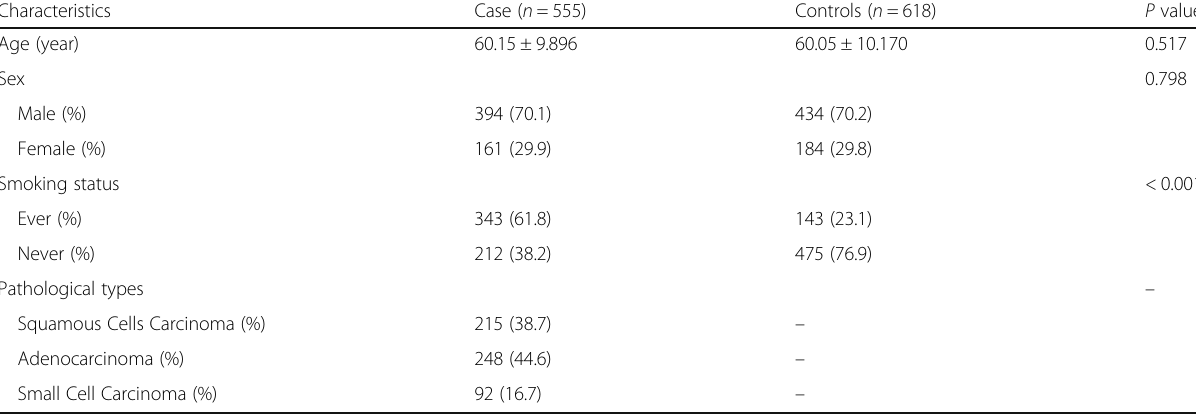
Table 2 Baseline characteristics of study subjects